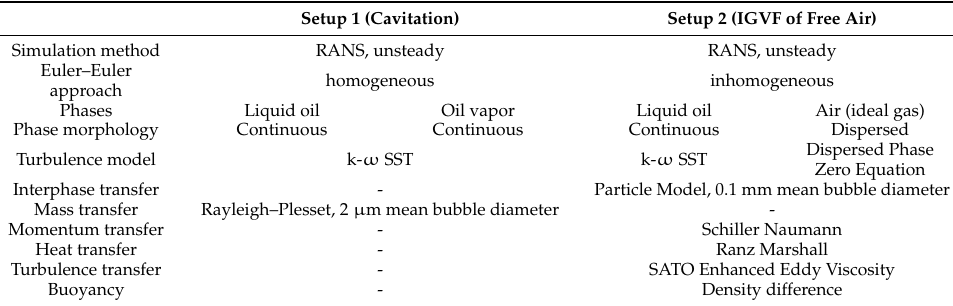
Table 2. Overview of the two CFD setups for multiphase flow simulations. Setup 1